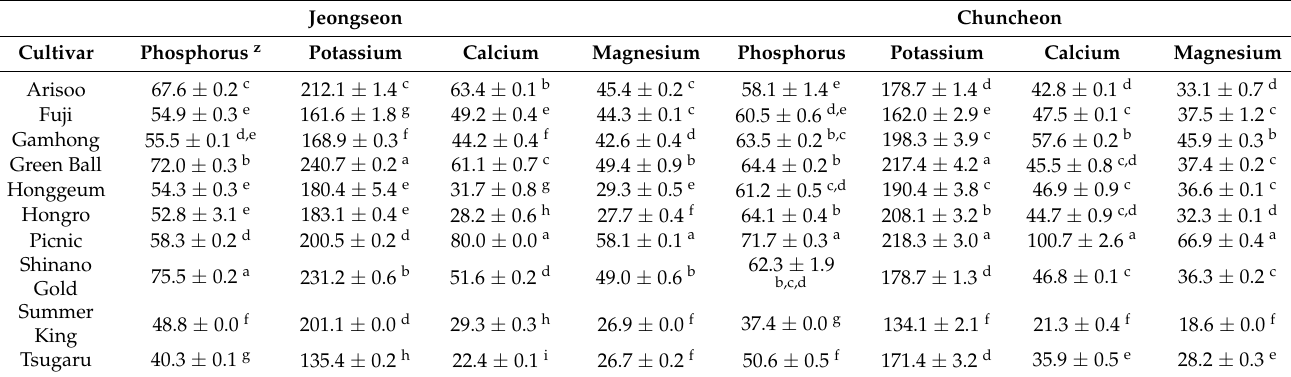
Table 5. Mineral contents in unripe apple fruits from two